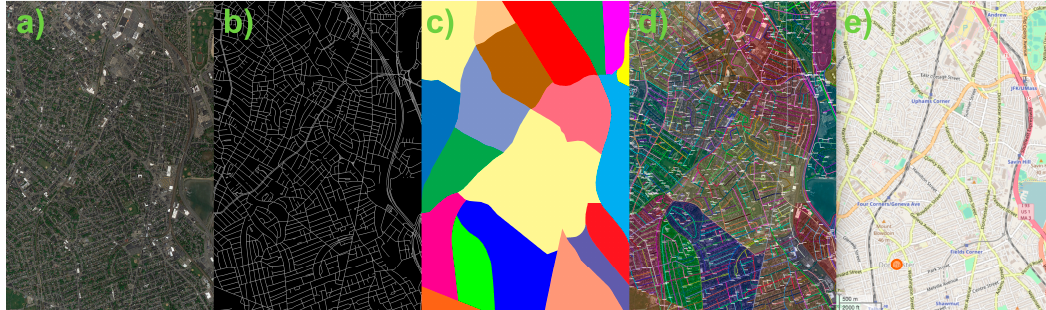
Figure 11. Stages of a Generative Map of a U.S. City. We show ( a ) the input satellite image tile; ( b ) the extracted roads; ( c ) the created regions; and ( d ) the generated map; compared to ( e ) the OpenStreetMap (OSM) of the same area. (Zoomed in for